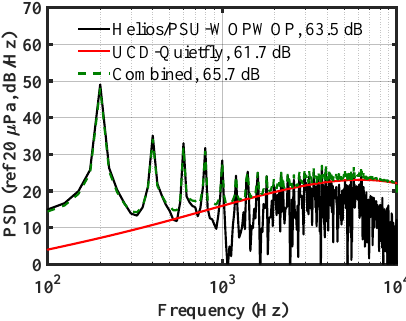
Figure 6. The acoustic spectra of a dual rotor case at an above-plane mic predicted by Helios/PSU- WOPWOP, UCD-Quietfly, and a combination of